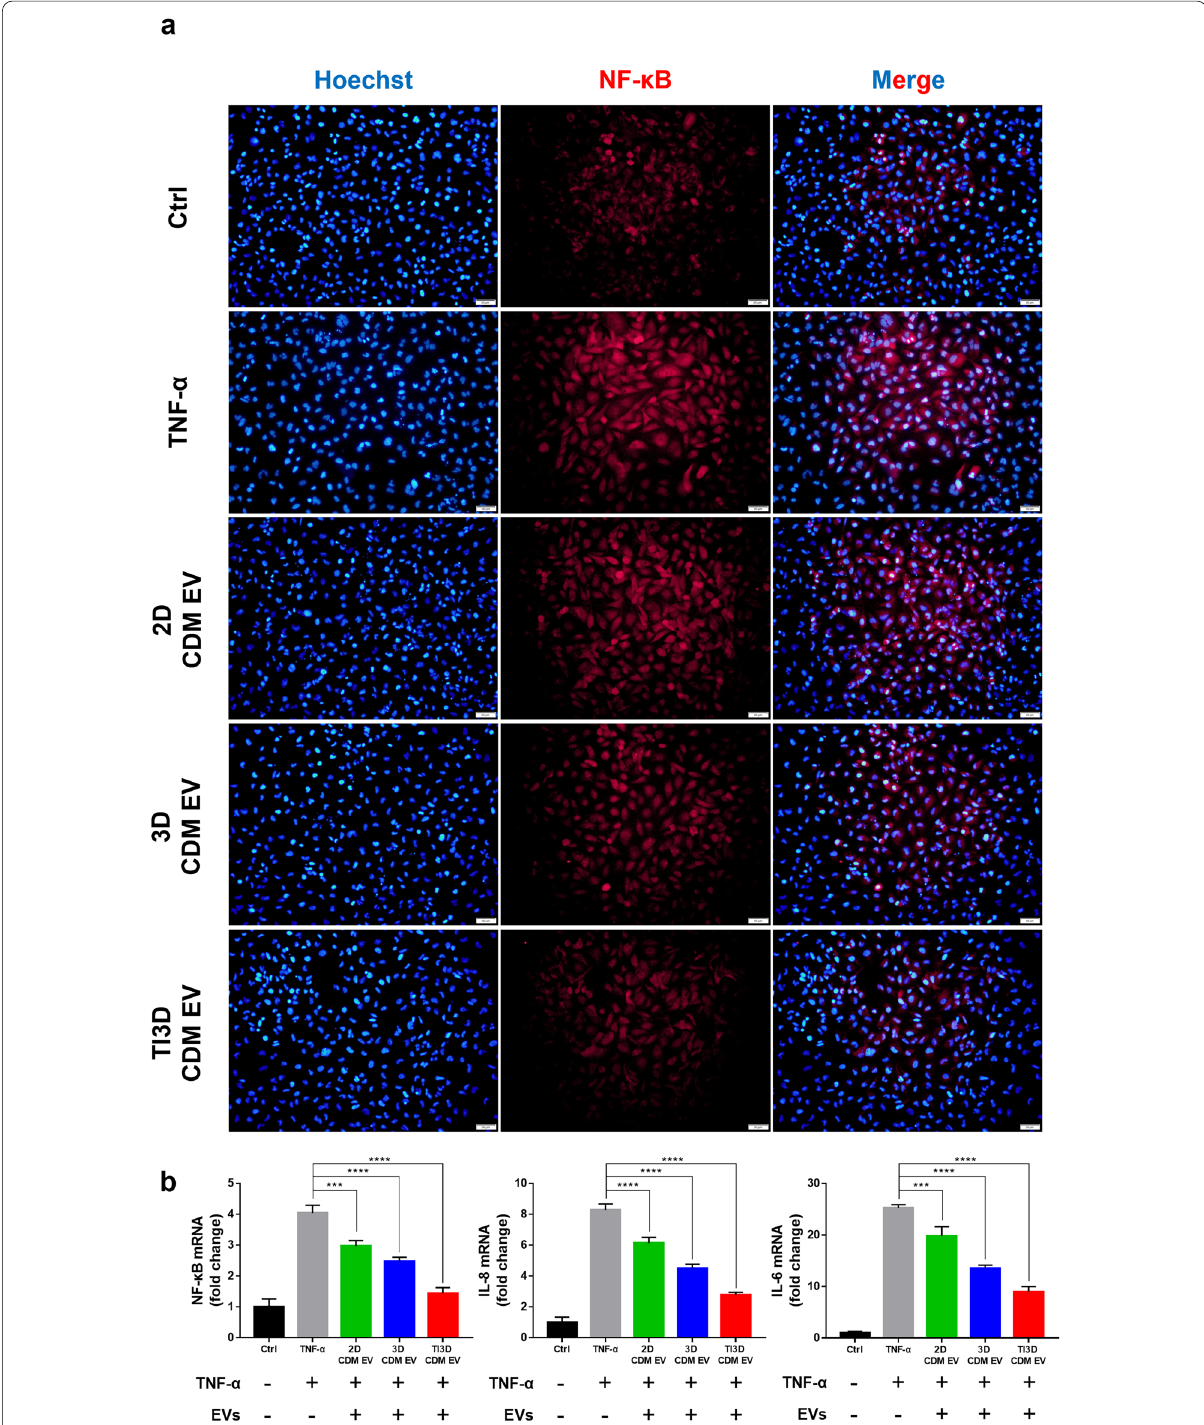
Fig. 6 Anti‑inflammatory activities of EVs. a The fluorescence‑based immunocytochemistry for NF‑κB expression of TNF‑α induced inflammation model with HK2 cells. b The gene expression levels of representative inflammatory factors, NF‑κB, IL‑8, and